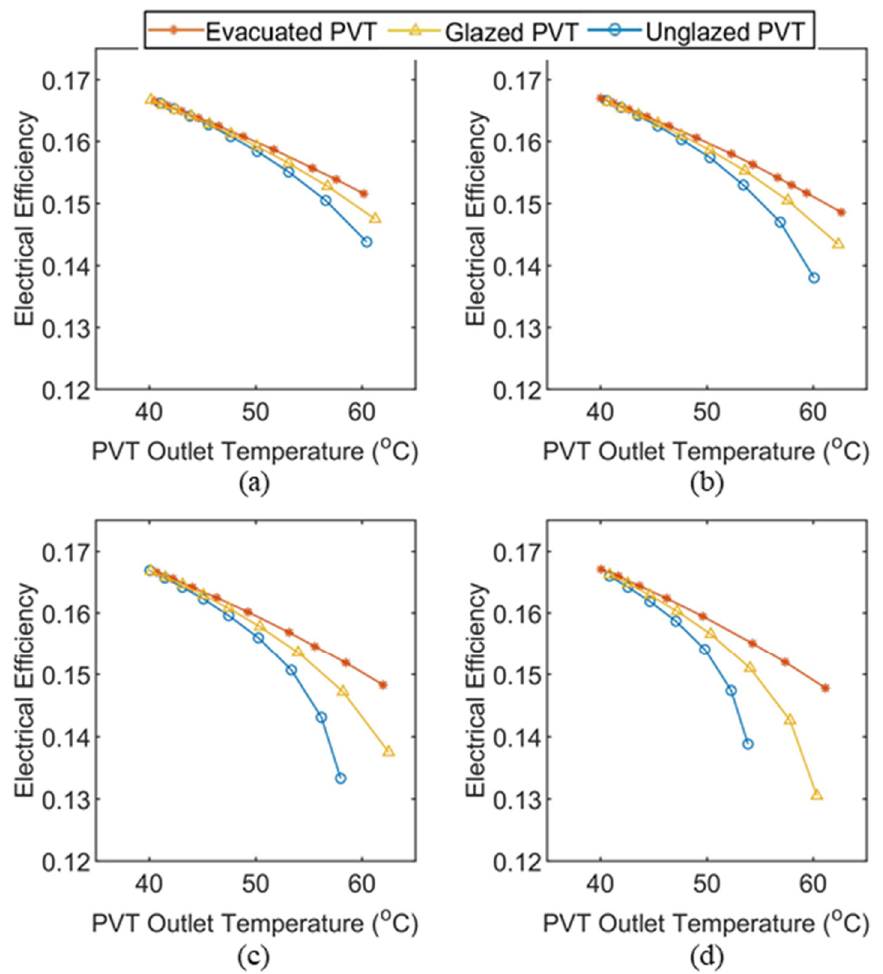
Figure 6. Electrical efficiency of different PVT systems versus outlet temperature at irradiance of: ( a ) 1000 W/m 2 ; ( b ) 900 W/m 2 ; ( c ) 800 W/m 2 ; ( d ) 700 W/m 2 .